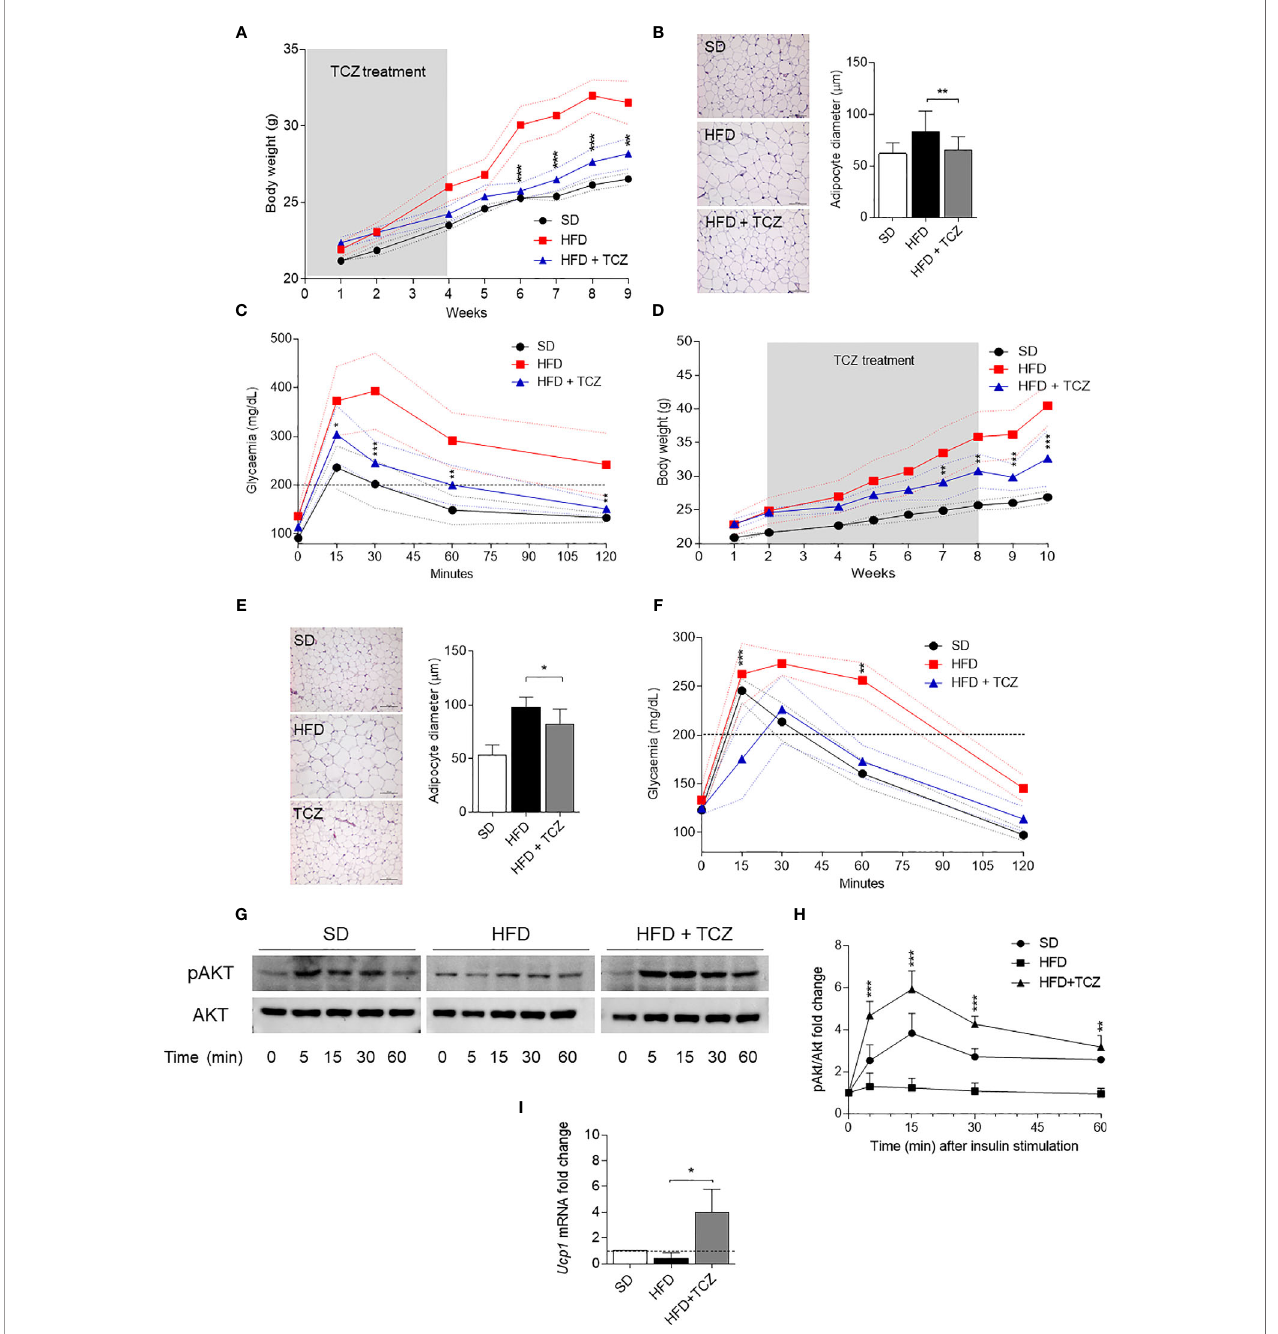
FIGURE 4 | TCZ effects in diet-induced obesity. (A, D) Body weight (g) of HFD-fed mice receiving TCZ 5 mg/Kg (HFD TCZ, n = 8) or saline (HFD, n = 8) administered i.p. compared with gender- and age-matched controls fed with a standard diet (SD, n = 8). TCZ treatment started with HFD (A) or 2 wk later (D) and ended after 4 and 6 weeks, respectively, in A and D (grey box). (B, E) Hematoxylin and eosin staining of visceral WAT (left panel, scale bars of 100 m m.). Analysis of adipocyte diameter (right panel). (C, F) Intraperitoneal glucose tolerance test (IPGTT) at the end of TCZ treatment. Glycaemia (mg/dl) was measured at different time points (0, 15, 30, 60, and 120 min) from the administration of glucose. (G, H) Immunoblot and quantitative analysis of insulin-driven AKT phosphorylation in ex vivo hepatocytes from mice represented in (D) . Data from two independent experiments (means ± S.D., n = 3 biological replicates per group) represent the fold change of the pAKT/AKT ratio in hepatocytes stimulated with insulin at the indicated times in which the calibrator is represented by pAKT/AKT ratio at time 0. (I) Gene transcription of Ucp1 in SVF WAT cells from mice represented in (D) . Data (mean ± S.D., n = 3 biological replicates per group) represent the fold change expression of Gapdh -normalized transcripts in which the calibrator is represented by samples from SVF WAT from SD-fed mice (fold change=1; dotted line). * p < 0.05, ** p < 0.01, *** p < 0.001; HFD TCZ versus HFD (ANOVA followed by post hoc Bonferroni ’ s